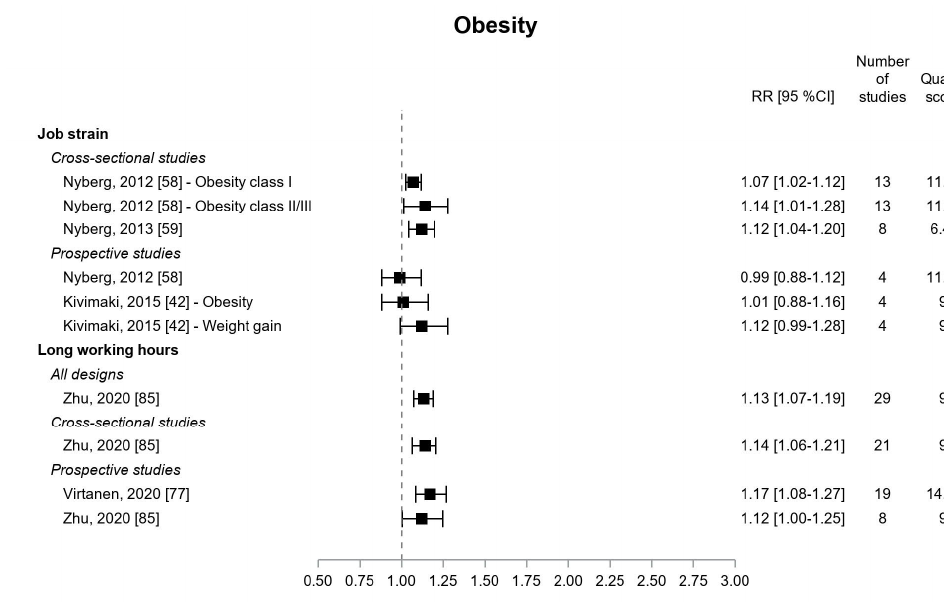
Figure 5. Pooled estimates for the associations between psychosocial work exposures and obesity. * IPD-Work Consortium studies without systematic literature